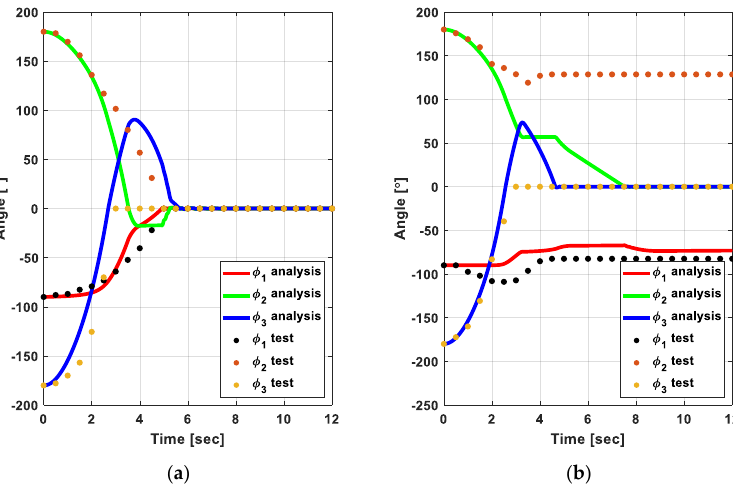
Figure 10. Comparison of the time history of angular displacements after EFT consideration for test cases: ( a ) T01, ( b ) T02.